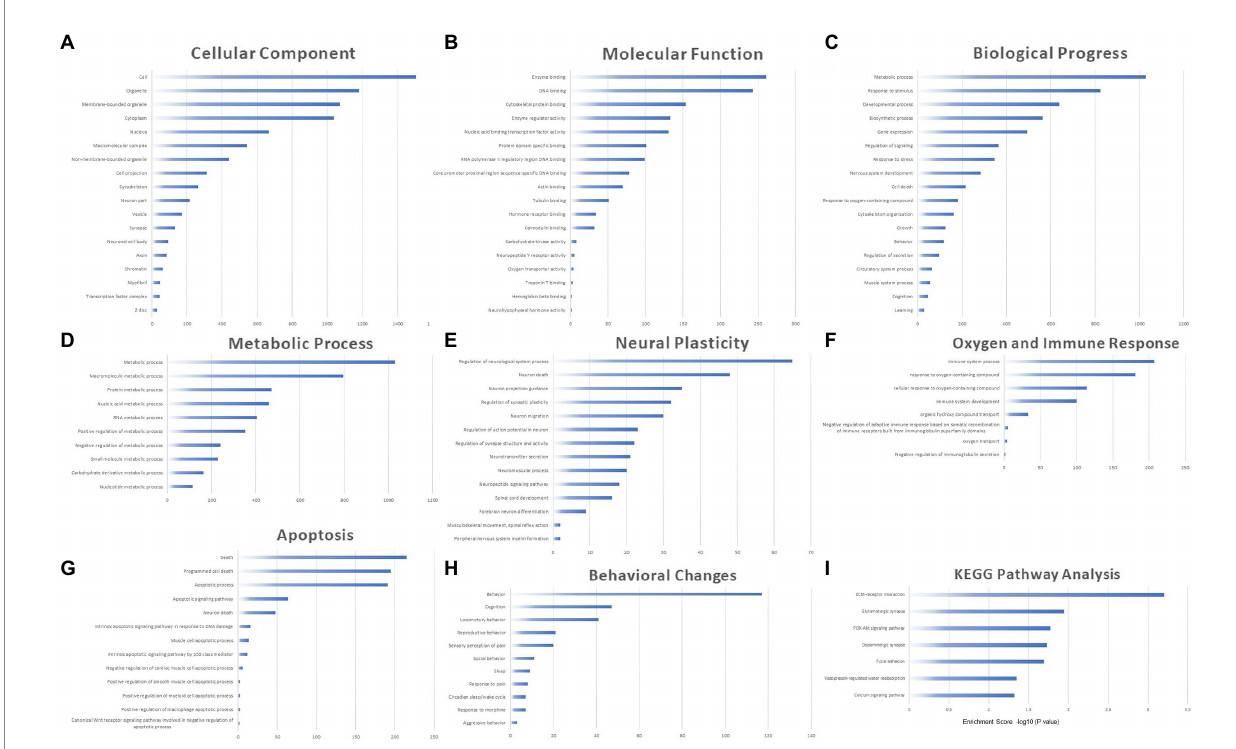
FIGURE 6 The biological role of 2,052 DEmRNAs through GO annotation and KEGG pathway enrichment analysis. The enrichment of 1762 GO terms including 153 cell components (A) , 256 molecular functions (B) , 1,353 biological processes (C) and 15 KEGG pathways (I) ( p < 0.05). Sub-categories of BP terms including metabolic process (D) , neural plasticity (E) , apoptosis (F) , behavior (G) and oxygen and immune response (H)